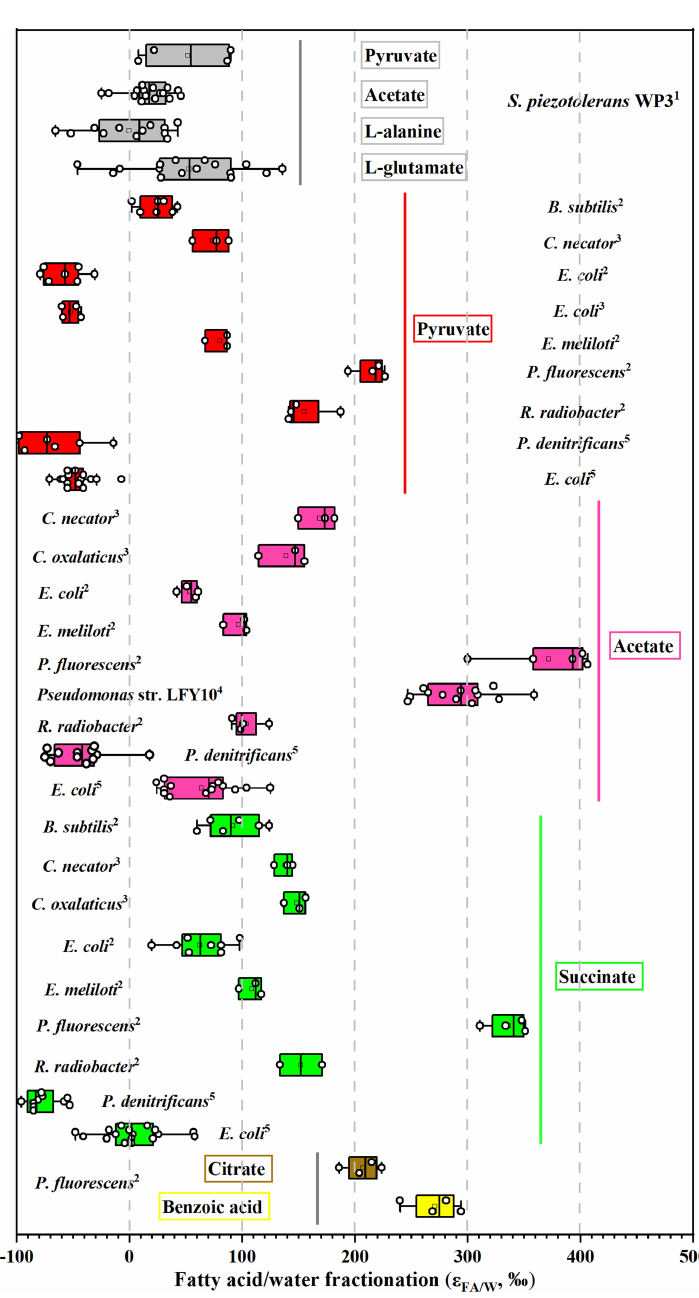
Figure 5. Compilation of measured hydrogen isotope fractionations growing on pyruvate and TCA cycle substrates. For each organism, bars represent the range of values for all individual fatty acids. The vertical line is the average value. Data sources: 1 this study; 2 Wijker et al. (2019); 3 X. Zhang et al. (2009); 4 , 5 Heinzelmann et al.